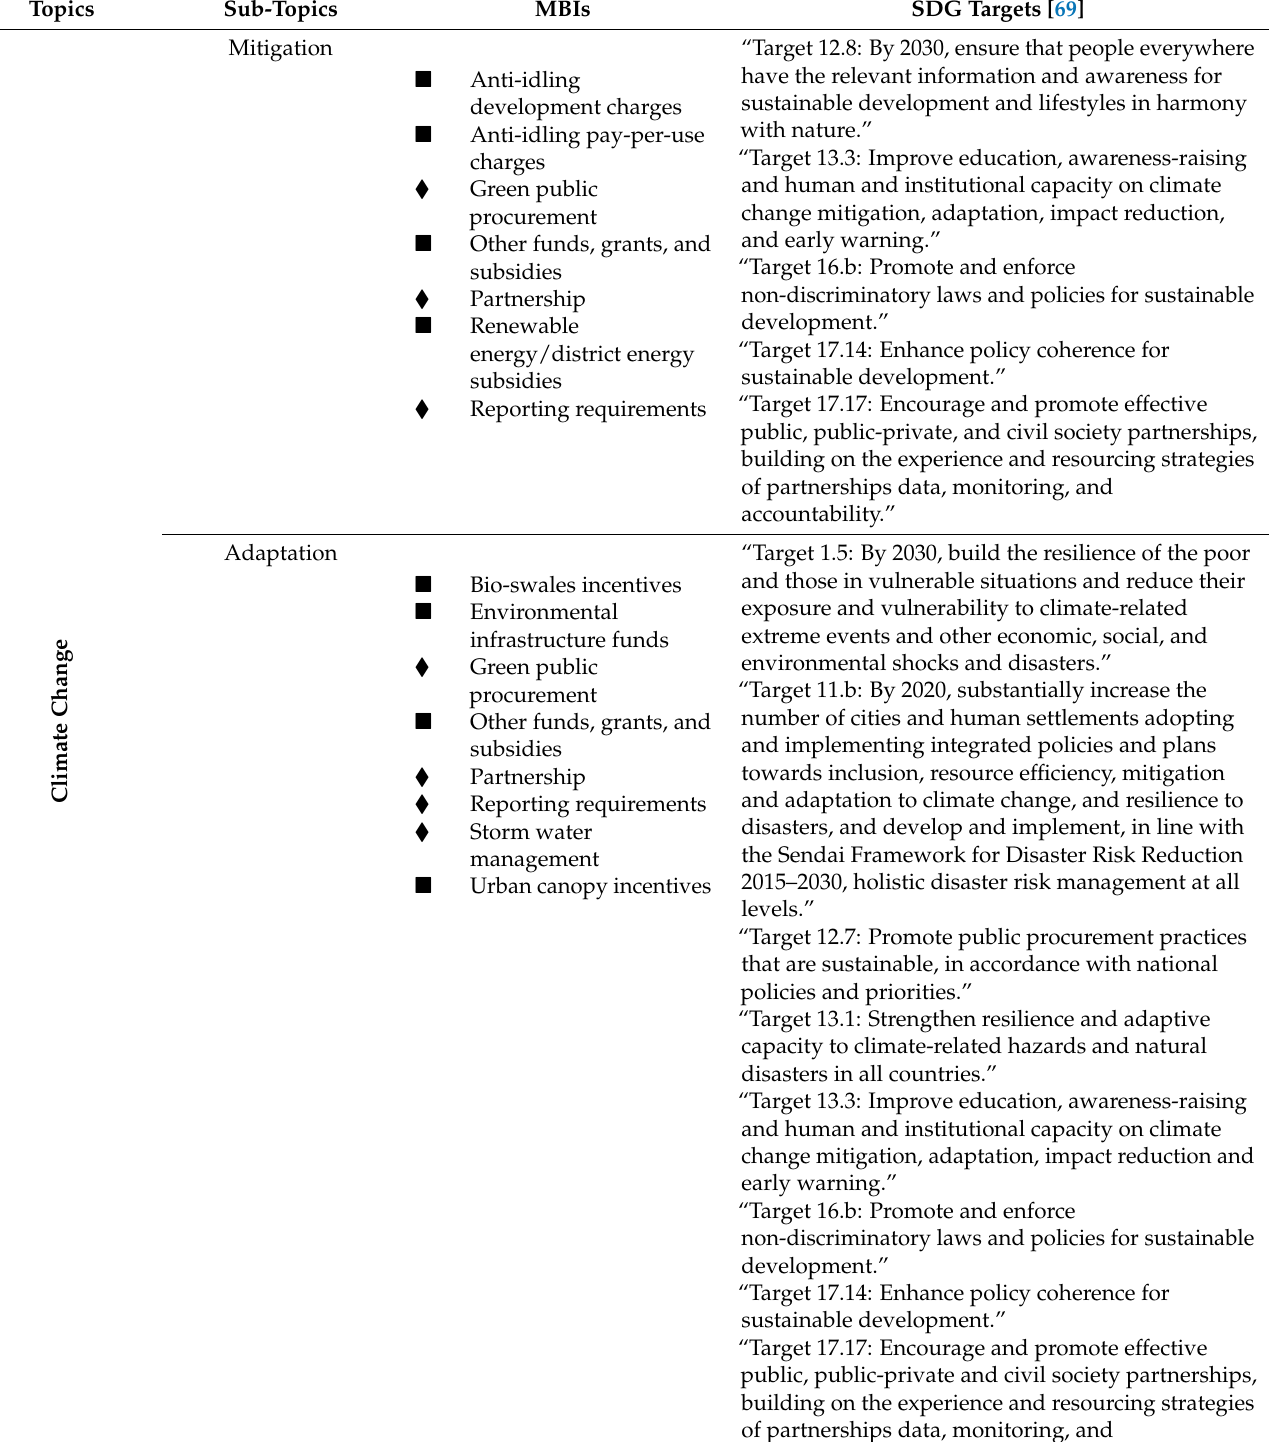
Table 8. Categorization of MBIs for Climate Change and Related SDG